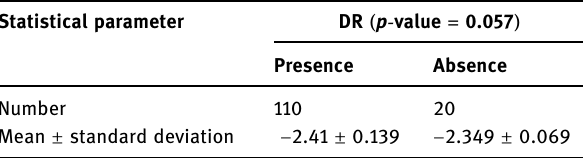
Table 4: Standard deviation and mean for DR in E - ophtha -